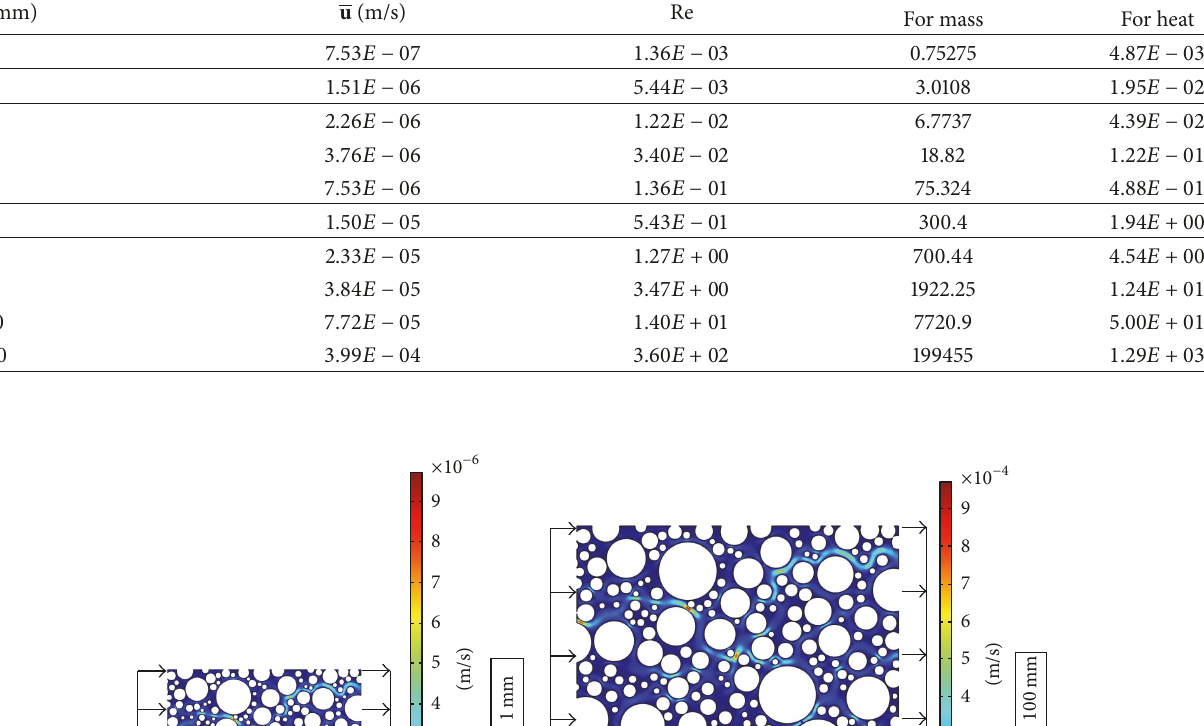
Table 2: The average velocity, Reynolds number, and P´eclet number of different length scales. Length scale 𝑙 (mm)